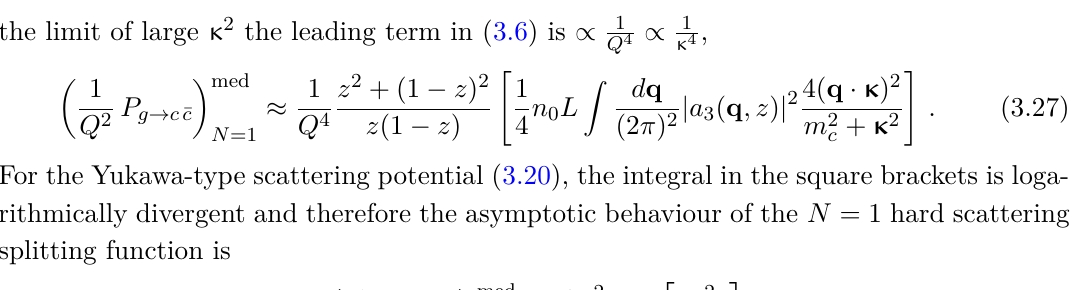
Figure 5 . Large- (cid:20) 2 -dependence of the medium-modified splitting function for N = 1 hard scat- tering approximation, illustrating the asymptotic behaviour (3.28), for particular values E (cid:1) GeV and 2 20 (cid:0) L = 2 GeV 2 µ 2 D 4 fm